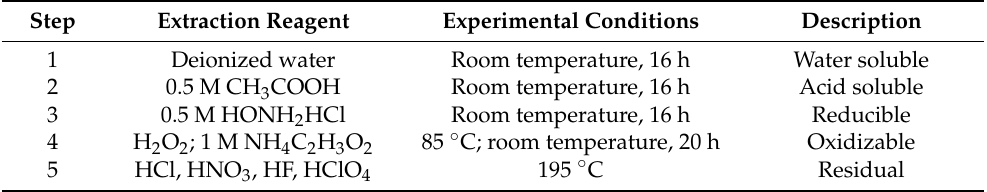
Table 2. BCR sequential extraction